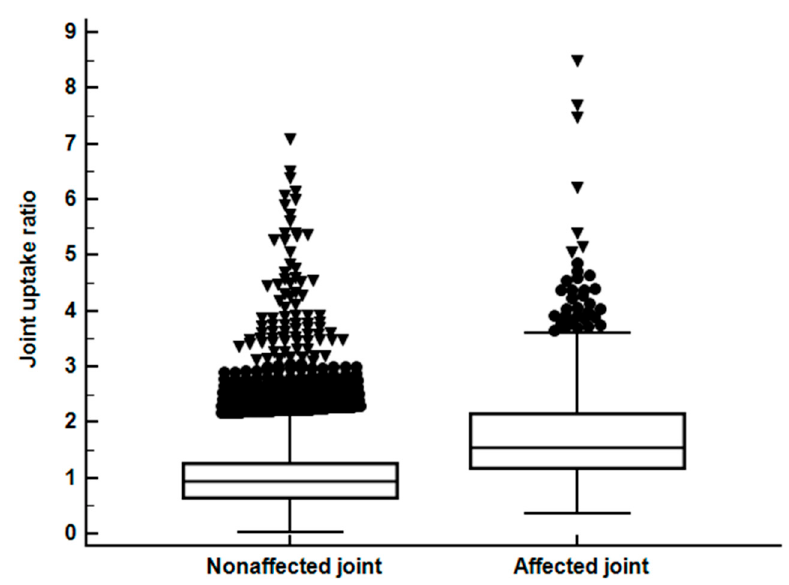
Figure 3. Distribution of the joint uptake ratio of 5213 nona ff ected joints and 728 a ff ected joints.